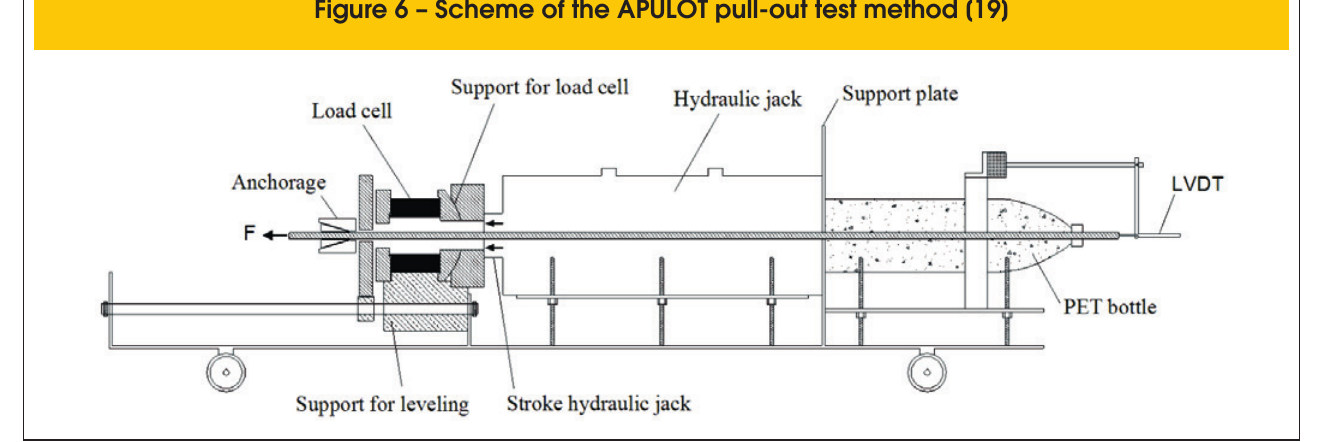
Figure 6 – Scheme of the APULOT pull-out test method